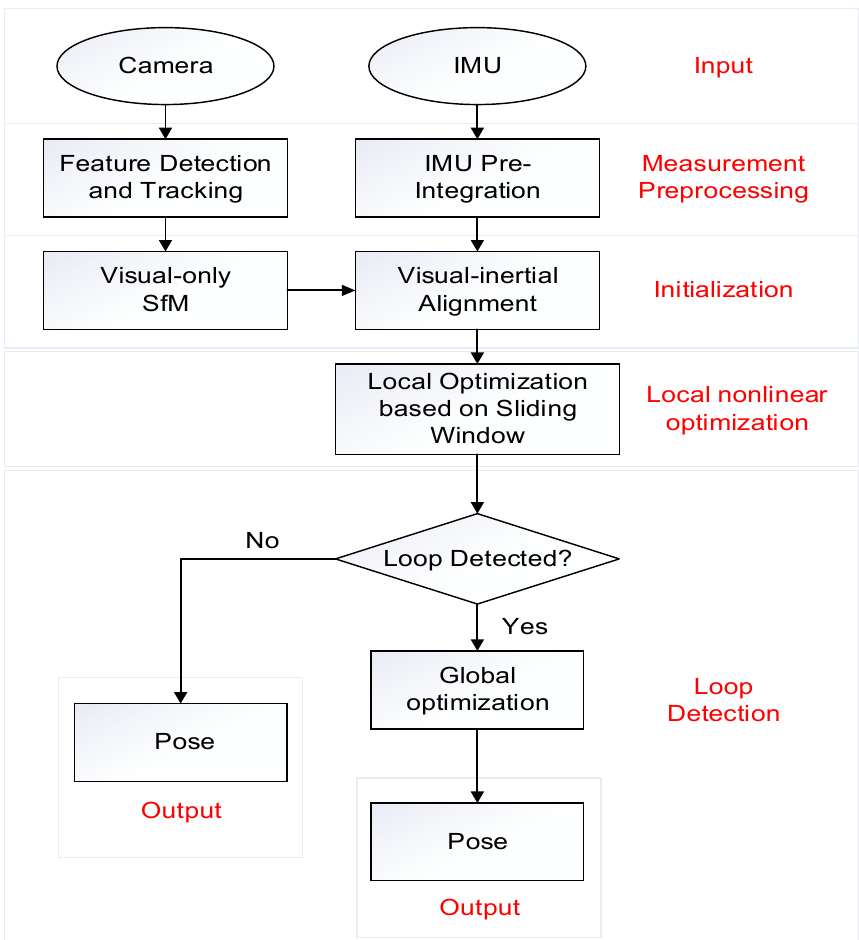
Figure 2. The flow chart of the visual inertial odometry (VIO) algorithm.